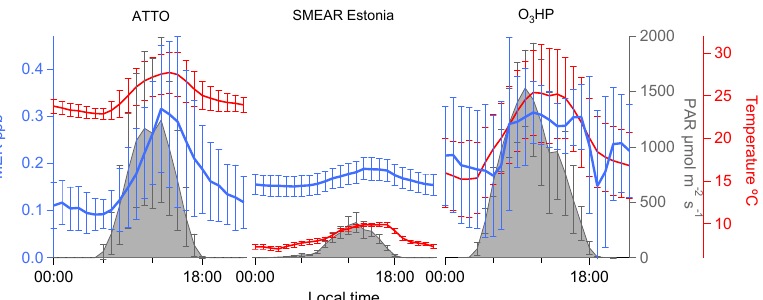
Figure 2. Hourly average diel cycles of MEK at the ATTO (left), SMEAR Estonia (middle) and O 3 HP (right) sites, for the period of measurements (wet season 2014 for ATTO at 38m October 2014 for SMEAR Estonia at 16m, and May and June 2014 for O 3 HP at 2m). Hourly mean diel cycles of temperature and PAR are also shown in red and grey, respectively. Error bars represent the standard